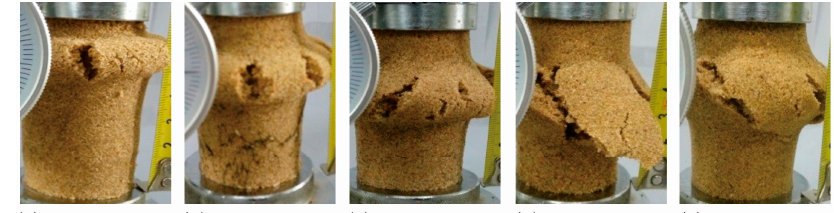
Figure 8. The shape of reinforced specimens after UCS test: ( a ) Polymer 10%; ( b ) Polymer 20%; ( c ) Polymer 30%; ( d ) Polymer 40%; ( e ) Polymer 50%.